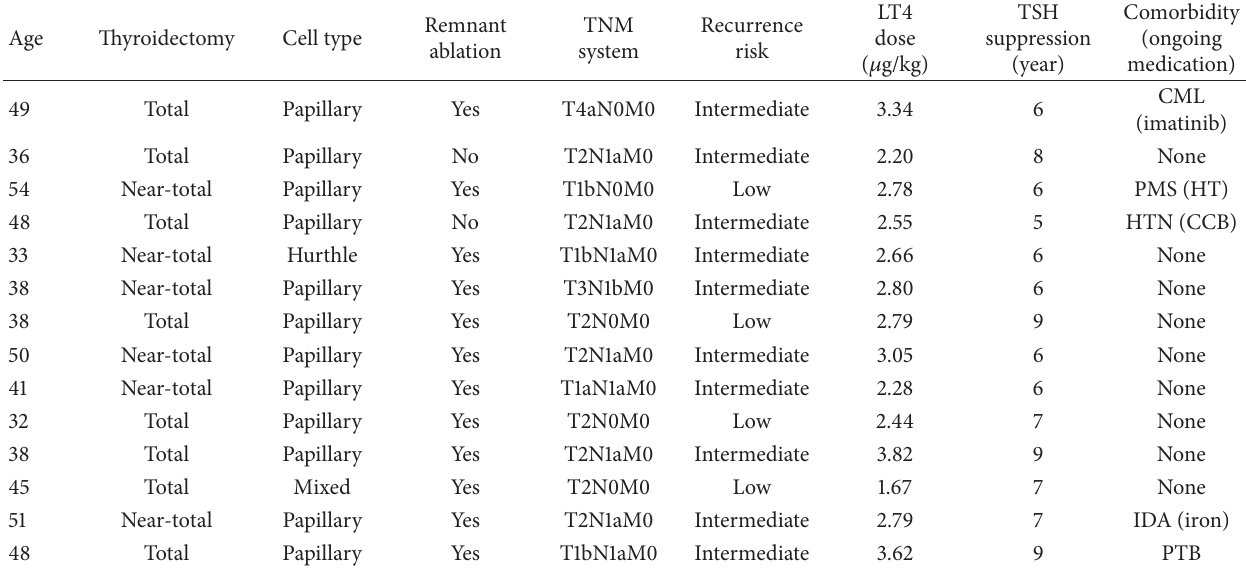
Table 1: Baseline characteristics of differentiated thyroid cancer patients based on TNM classification and recurrence-risk stratification